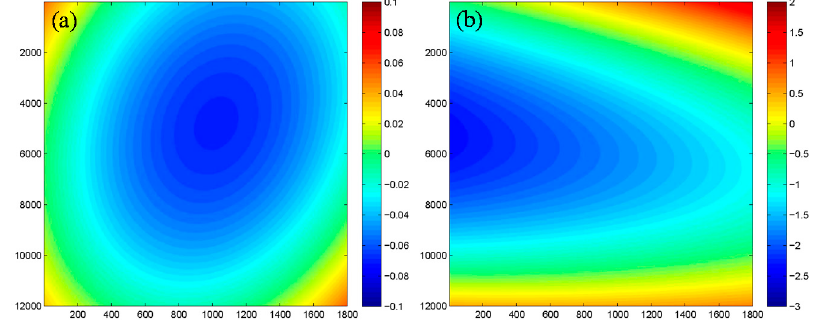
Figure 5. The difference of the offsets derived from the identified TCPs and evenly-distributed windows over the whole image in range ( a ) and azimuth ( b ) directions, respectively. Unit: pixel. The figure is plotted in the SAR coordinate system. Table 2. The polynomial coefficients ( a ~ f ) determined from the offsets. The range and azimuth coordinates of pixels are labeled by i and j ,